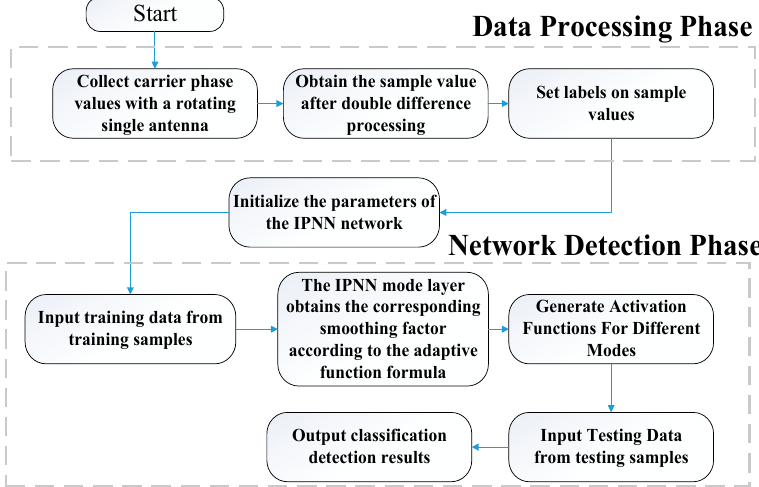
Figure 4. Spoofing Detection Process .